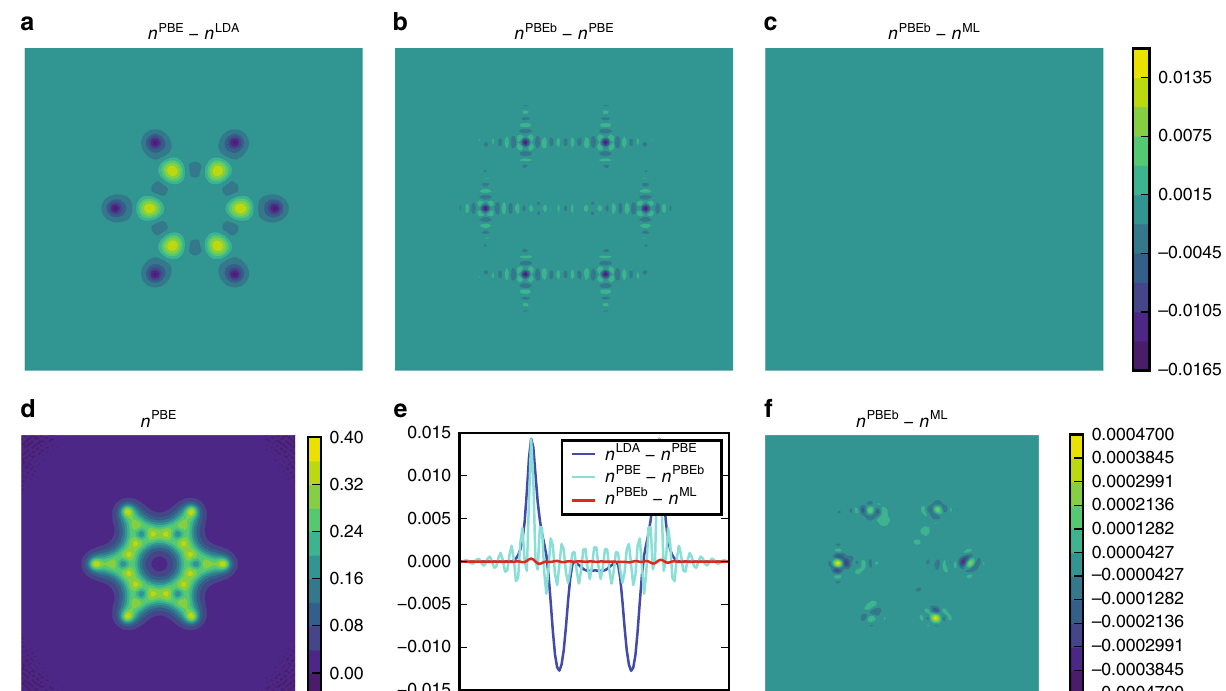
Fig. 4 The precision of our density predictions using the Fourier basis for the molecular plane of benzene. The plots show a the difference between the valence density of benzene when using PBE and LDA functionals at the PBE-optimized geometry. b Error introduced by using the Fourier basis representation. c Error introduced by the n ML [ v ] density fi tting ( a – c on same color scale). d The total PBE valence density. e The density differences along a 1D cut of a – c . f The density error introduced with the ML-HK map (same data but different scale, as in c )